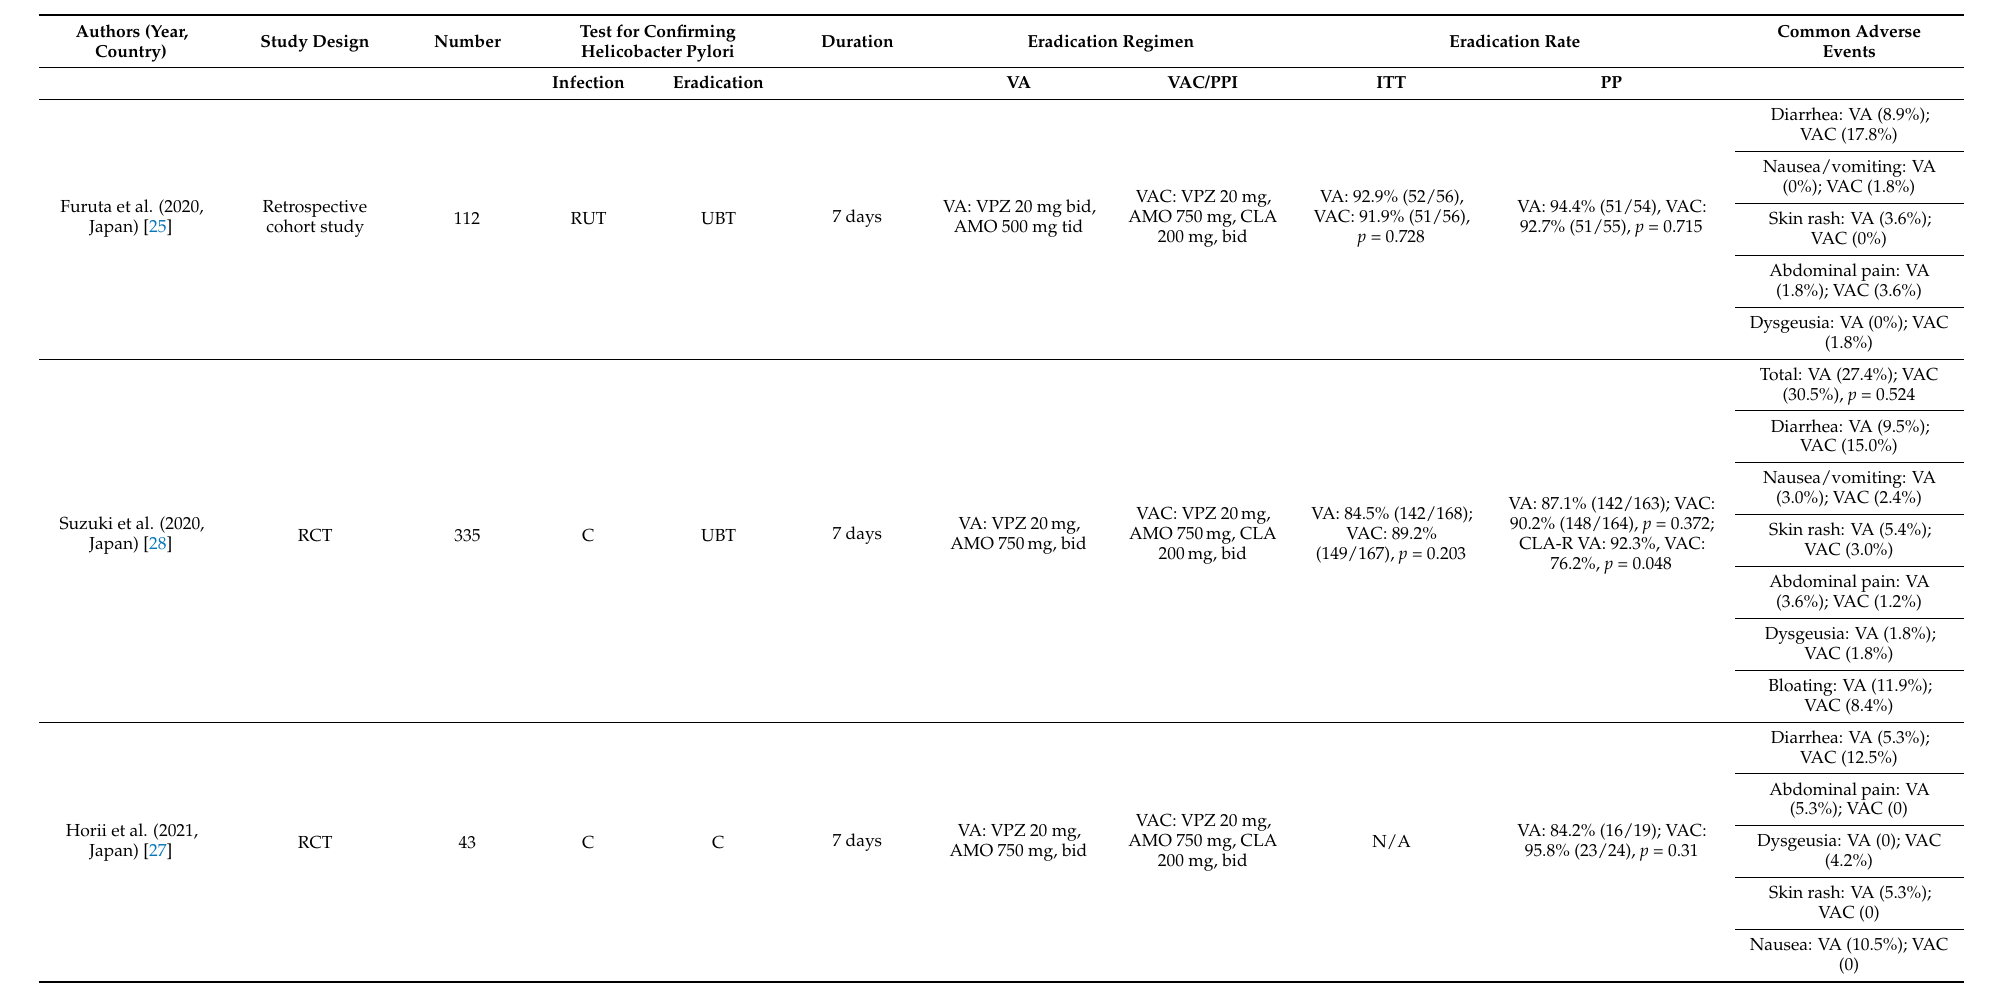
Table 1. Characteristics of studies included in the network